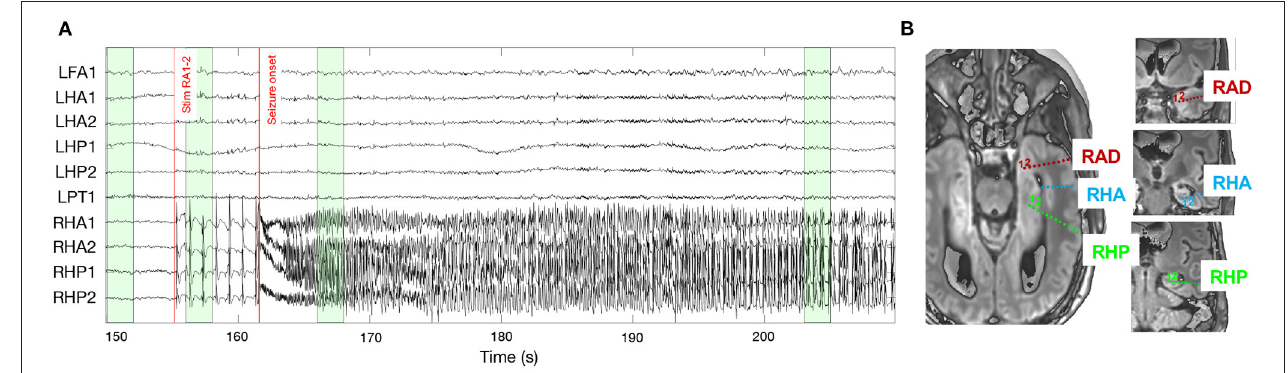
FIGURE 2 | (A) Local field potentials as measured from the contacts included in the connectivity analysis. The two red lines indicate the start of the stimulation in the right amygdala, and the onset of the epileptic seizure. The green boxes highlight the epochs on which connectivity is computed ( t 166 168, and 203 205 s). The epoch at the end of the EEG recording is not visualised because it lies far outside the displayed window ( t − − (B) Position of the implanted electrodes in the right amygdala (RAD, red), anterior hippocampus (RHA, blue), and posterior hippocampus (RHP, green). Because of the implantation angle of the electrodes, some contacts are not visible on the axial plane (e.g., for the right anterior hippocampus, the most medial contacts cannot be seen), so coronal views (right) are also added. On each electrode, the most medial contact corresponds to contact 1.